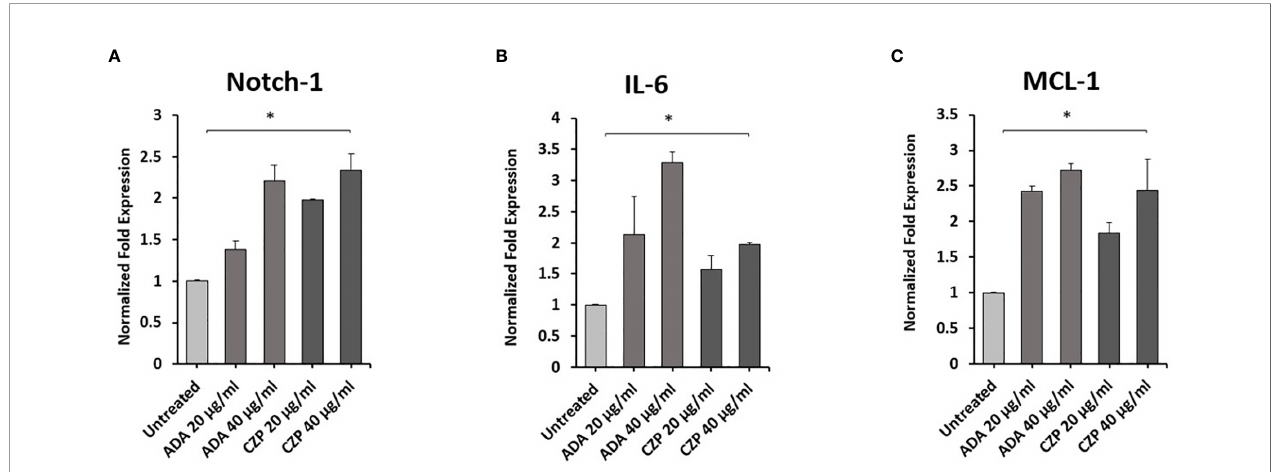
FIGURE 1 | Anti-TNF- a agents induce Notch-1 and its downstream effect on IL-6 and MCL-1. THP-1 derived macrophages were treated with non-PEGylated (ADA) and PEGylated (CZP) anti-TNF- a agents (0-40 m g/ml). The expression level of (A) Notch-1, (B) IL-6, and (C) MCL-1 were detected by RT-PCR. All experiments were performed in triplets. Data are shown as mean ± SD, and signi fi cance is considered as *P <